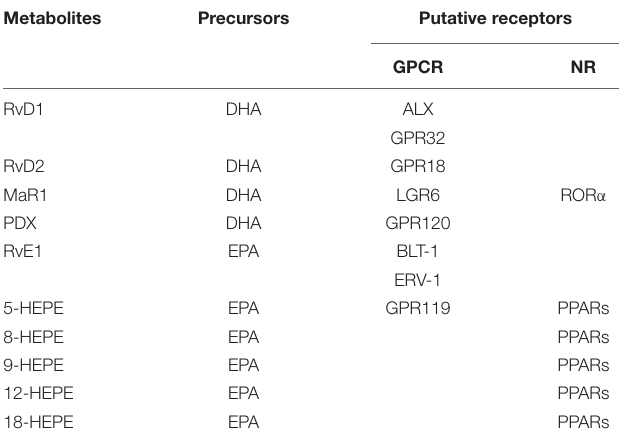
TABLE 1 | The receptors of ω -3 PUFA-derived bioactive